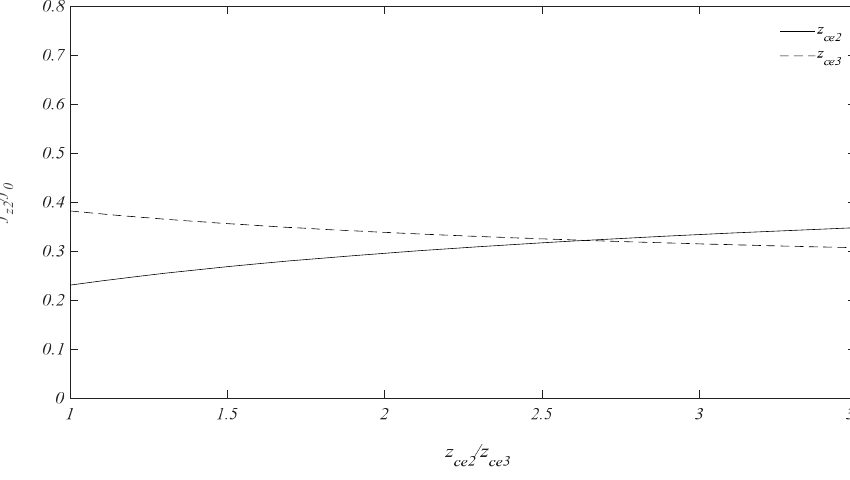
Figure 3. Simulated frequency responses of the CLCSR filter with varied designing parameters z ce 2 and z ce 3